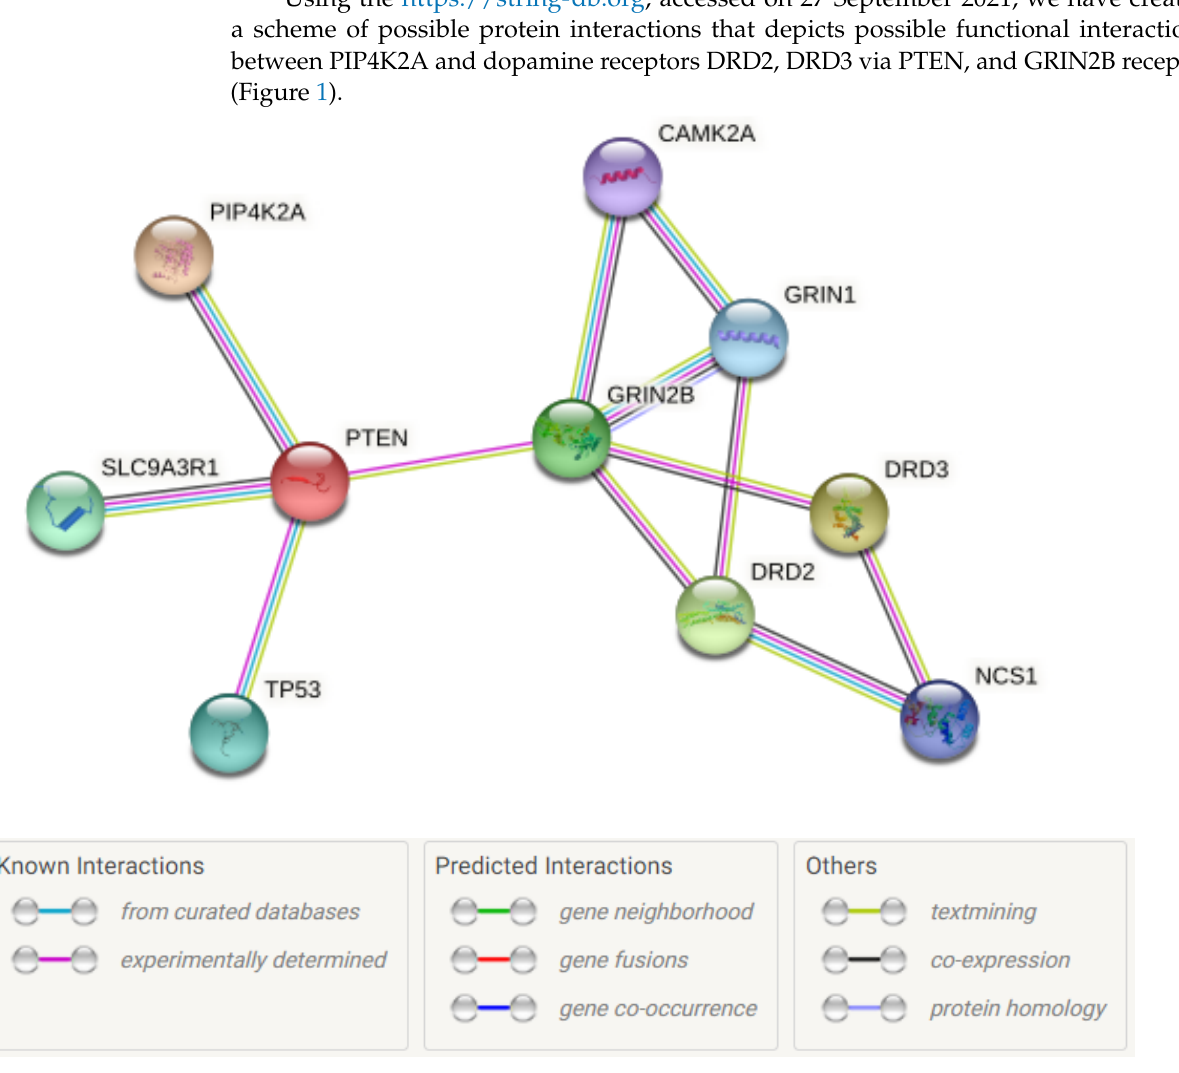
Figure 1. Scheme of possible protein interactions between PIP4K2A and dopamine receptors DRD2, DRD3 created using the https://string-db.org, accessed on 27 September 2021.